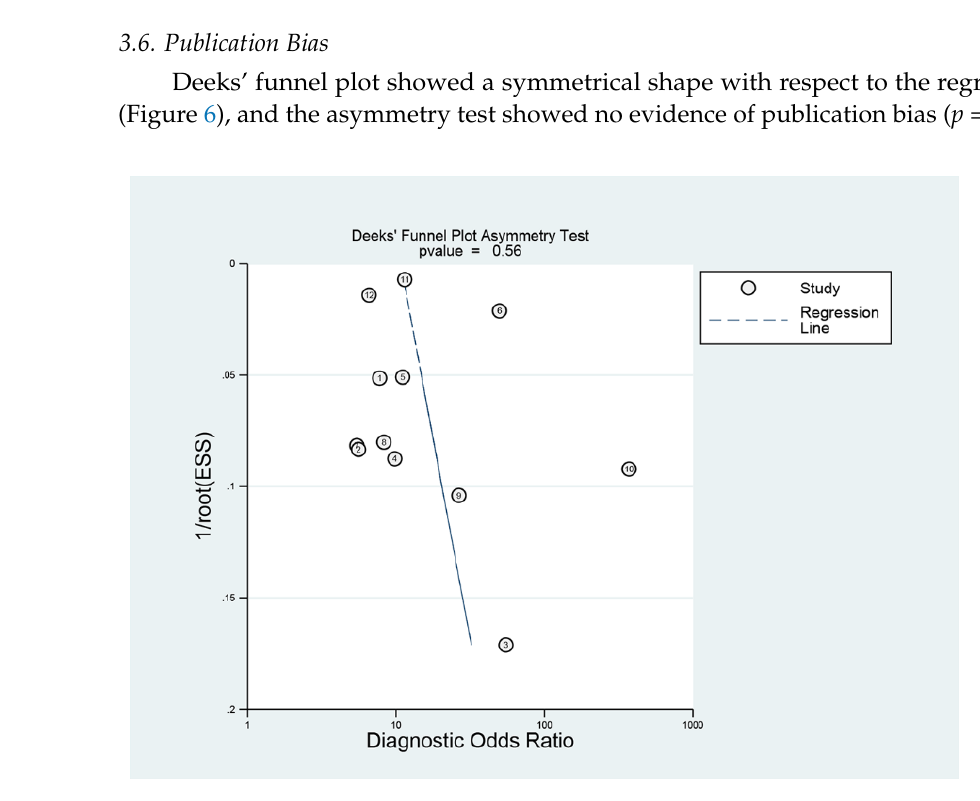
Figure 6. Deek’s funnel plot of computer -aided diagnosis models for the diagnosis of gastrointesti- nal protruded lesions in wireless capsule endoscopy images. protruded lesions in wireless capsule endoscopy